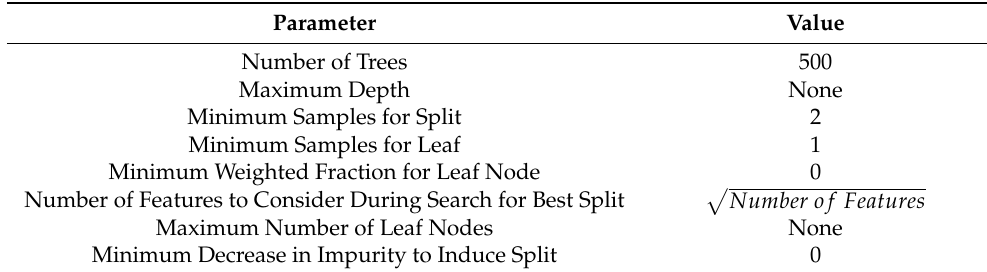
Table 3. Parameters values used for the random forest classifier algorithm in scikit-learn. All values are the default options except for the number of trees. Parameter Value Number of Trees 500 Maximum Depth None Minimum Samples for Split 2 Minimum Samples for Leaf 1 Minimum Weighted Fraction for Leaf Node 0 (cid:112) Number of Features to Consider During Search for Best Split Number of Features Maximum Number of Leaf Nodes None Minimum Decrease in Impurity to Induce Split